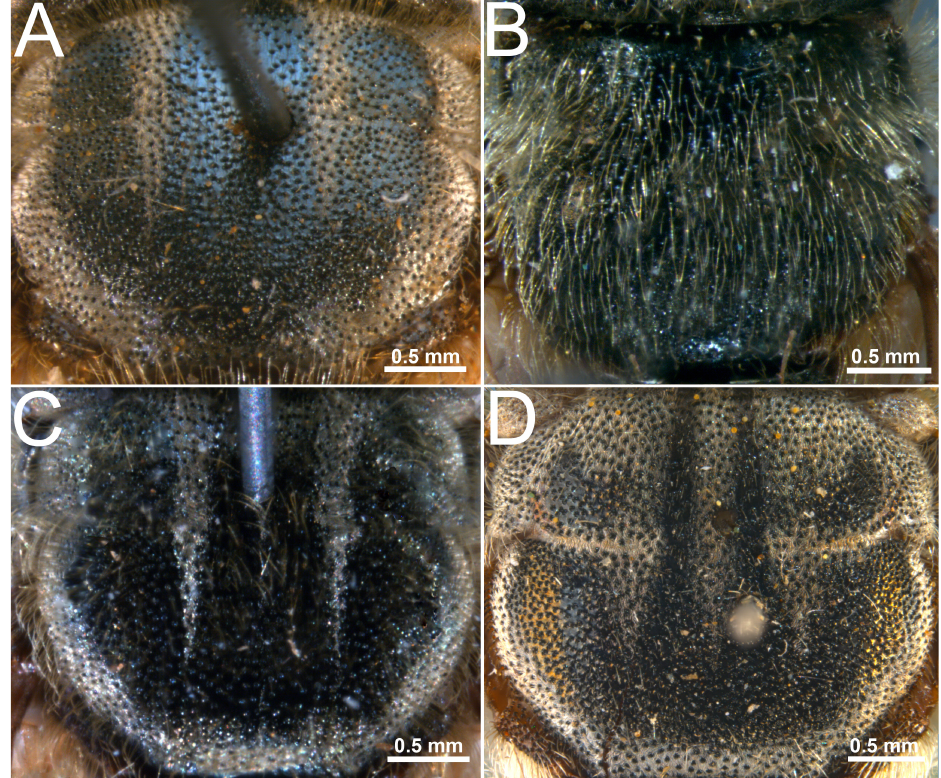
Fig. 4. Megatrigon spp., mesoscutum, dorsal view. A . Megatrigon magnicornis sp. nov. (♂). B . M. natalensis sp. nov. (♂). C . M. apiformis sp. nov. (♂). D . M. nivalis (Hull, 1964) comb. nov.